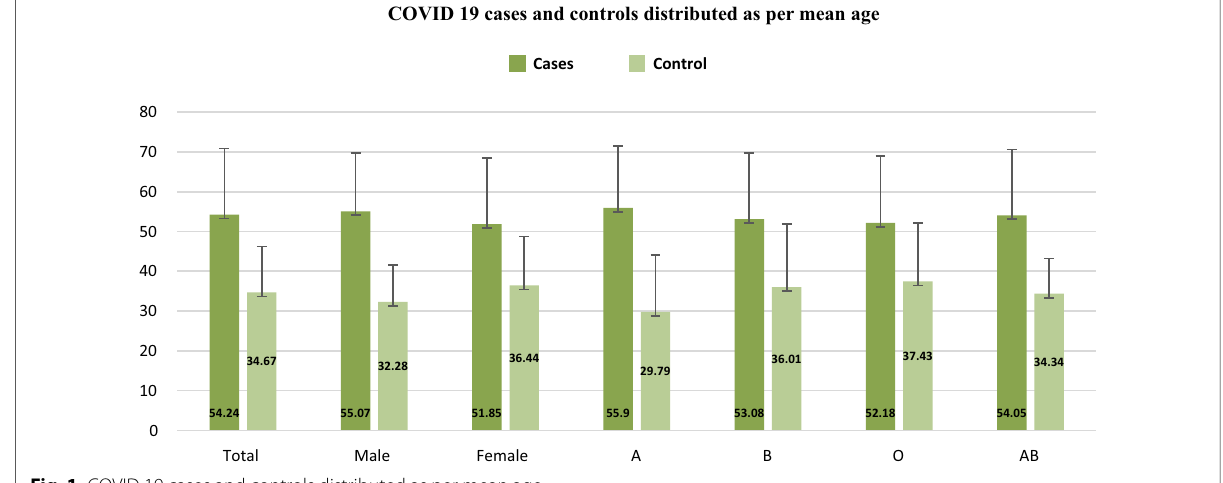
Fig. 1 COVID 19 cases and controls distributed as per mean age